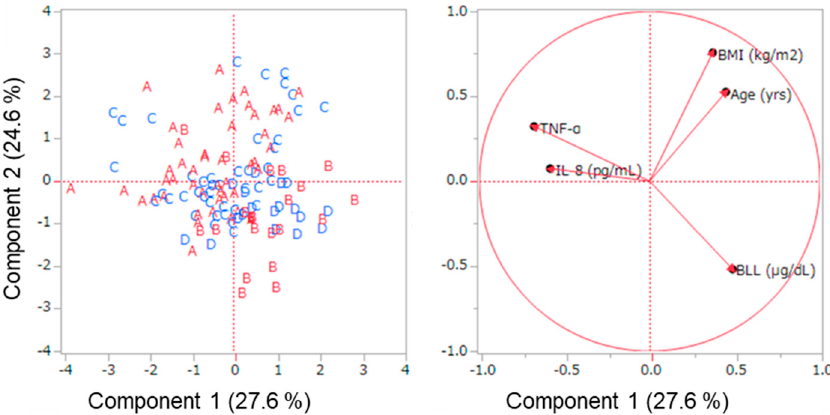
Figure 2. Principal component analysis of the plasma cytokines, tumor necrosis factor alpha (TNF- α )